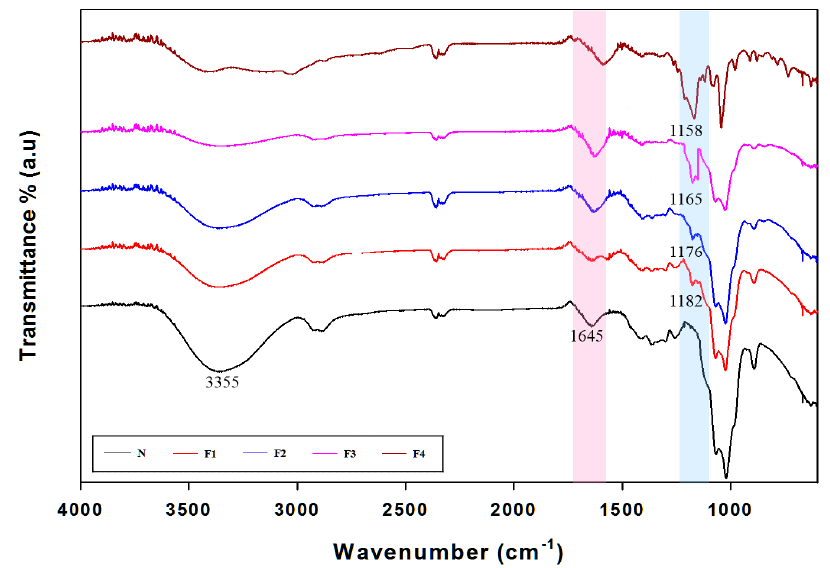
Figure 5. ATR-FTIR spectra of N fraction and anionic CG fraction region from 4000 to 600 cm − 1